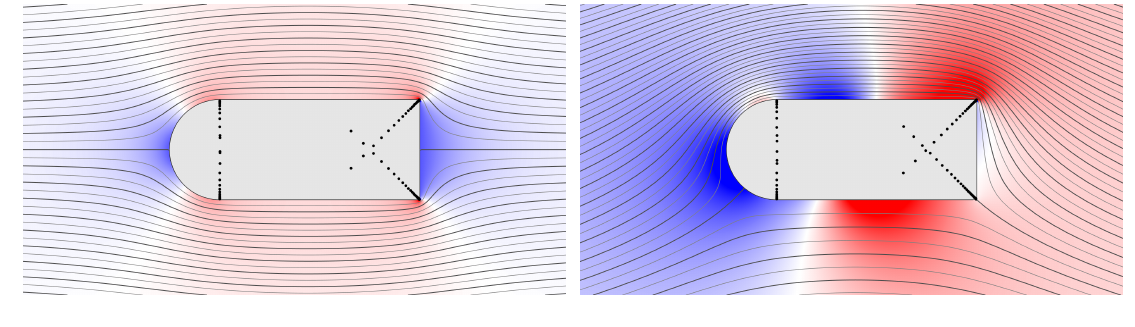
Figure 5. An illustration of the effects of the Kutta condition on the flow past a bullet-shaped object. The solutions are computed to 6 digits of accuracy; in ( a ) the solver takes 0.3 s and in ( b ) the solver takes 0.8 s. The color scale is the same in both